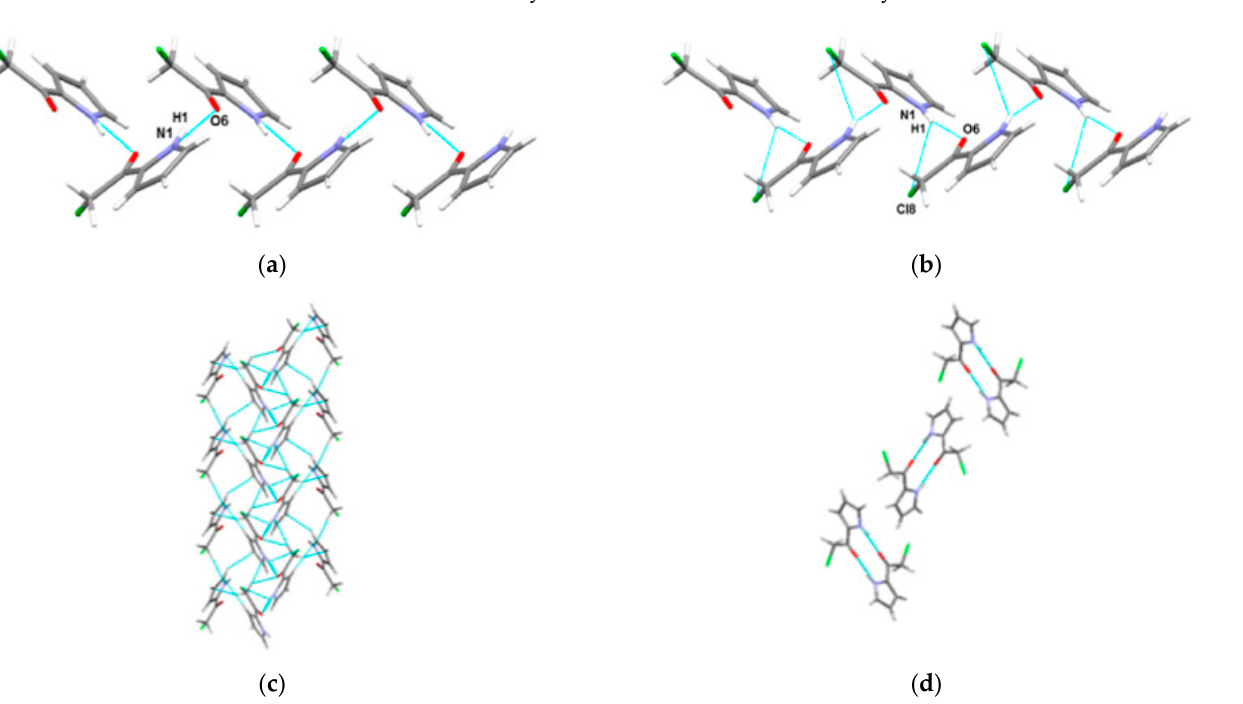
( b ) Figure 6. Molecular arrangement in structure III . ( a ) An a -axis viewed chain of N-H ⋯ O. H-bond parameters [N1-H1 ⋯ O6] N1-H1 0.88(2)Å, H1 ⋯ O6(1-x,1/2+y,1/2-z) 2.06(2)Å, <N1H1O6 171(1)°. ( b ) View of the N-H ⋯ O chains connected by C-H ⋯ O hydrogen bonds and stabilized by C-H ⋯ π interac- tions. H-bond parameters [C8-H82 ⋯ O7] C8-H82 0.97(2)Å, H82 ⋯ O7(1-x, − 1-y,1-z) 2.63(2)Å, <C8H82O7 156(1)°, [C5-H5 ⋯ Cg1] C5-H5 0.95(2)Å H5 ⋯ Cg1 (1-x,1/2+y,1/2-z) 2.64(2)Å, <C5H5Cg1 139(1)°.